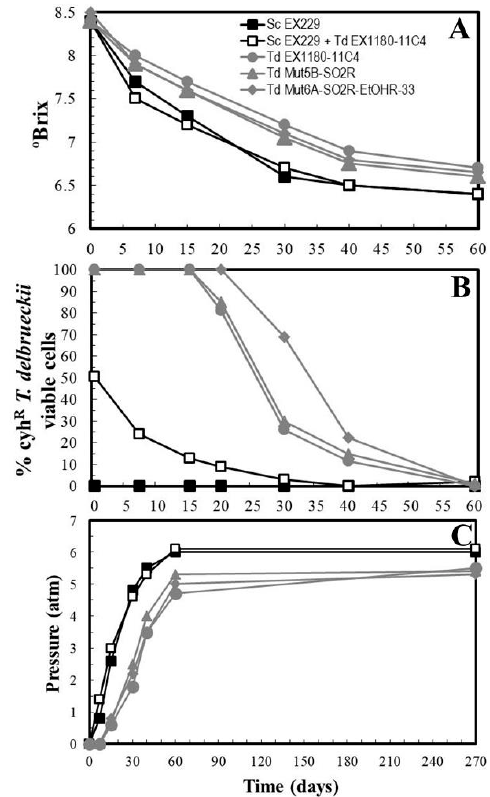
Figure 4. Fermentation kinetics and yeast-population dynamics during sparkling wine second-fermentations inoculated with T. delbrueckii mutants resistant to SO 2 and ethanol. Garnacha base wine was single inoculated with Sc EX229, Td EX1180-11C4, Td Mut5B-SO2R or Td Mut6A-SO2R-EtOHR-33, or mixed inoculated with Sc EX229 + Td EX1180-11C4. ( A ) Evolution of sugar consumption ( ◦ Brix). ( B ) Percentage of cyh R yeast cells in each fermentation. Note that the cyh R T. delbrueckii viable cells tended to disappear as CO 2 pressure increased. ( C ) Pressure inside the bottle. Data are the mean values of three fermentations inoculated with each yeast strain. Standard deviations were less than 13% of the means.